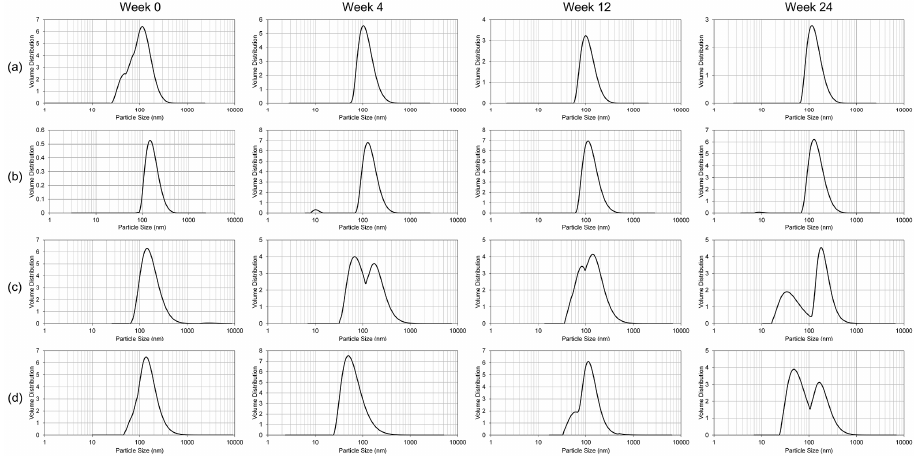
Figure 3. Particle size distribution over time for ( a ) liquid blank NE; ( b ) liquid GT3 NE; ( c ) lyophilized blank NE; and ( d ) lyophilized GT3 NE stored at 4 °C.